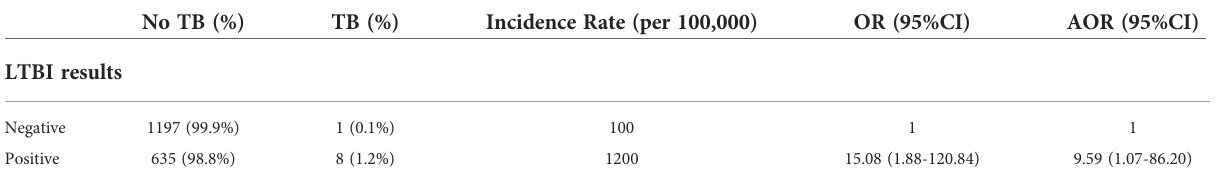
TABLE 4 The risk of tuberculosis incidence of participants during the one-year follow-up period according to baseline latent tuberculosis infection status. The cumulative tuberculosis incidence of participant during the one-year observation